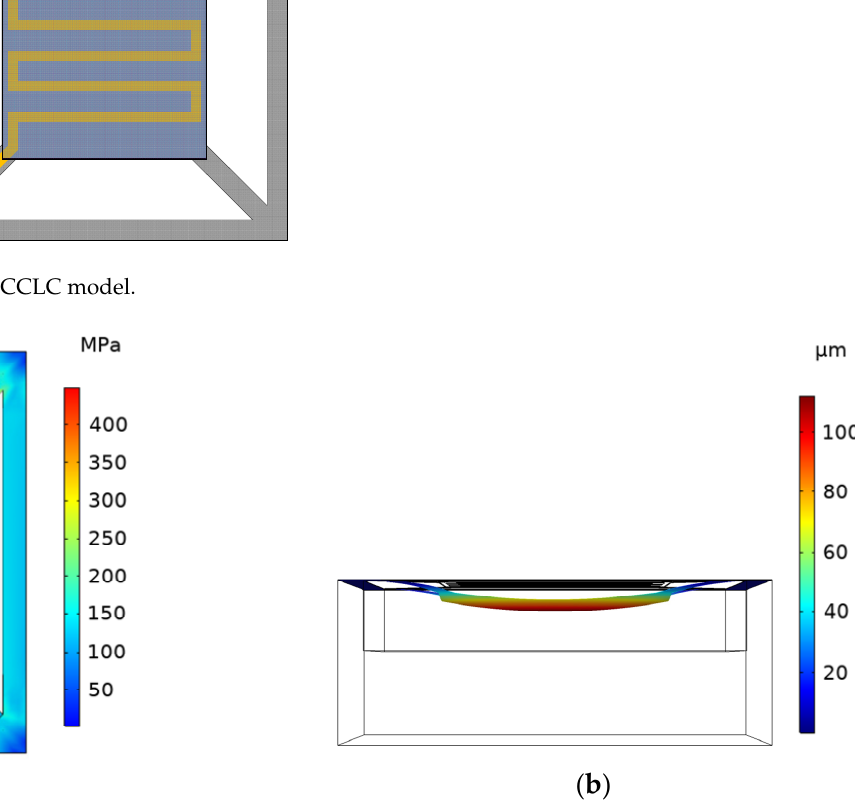
Figure 4. Cloud diagram of stress, and deformation displacement simulation of CCLC model. ( a ) Cloud diagram of stress simulation; ( b ) cloud diagram of deformation displacement simulation .